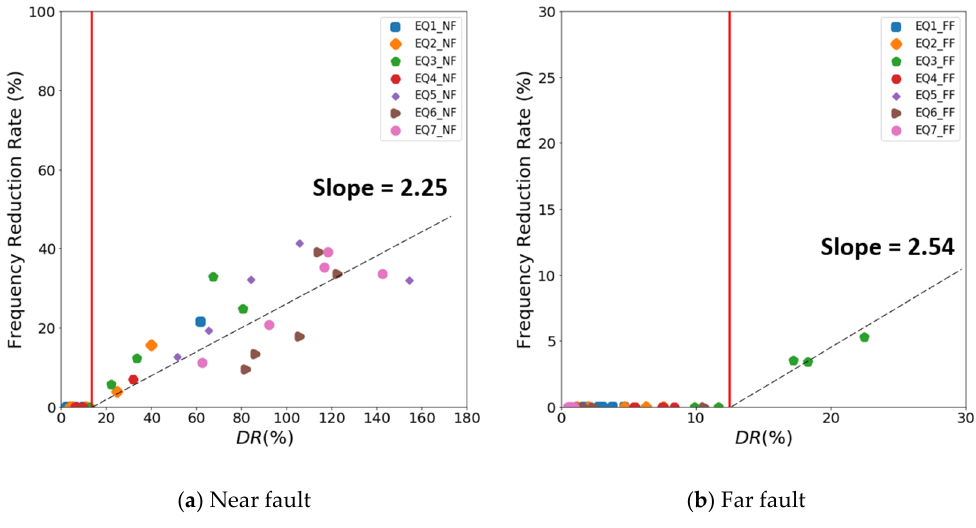
Figure 15. Relationship between the decrease in the natural frequency and the dynamic response ratio ( DR) : ( a , b ) The decrease in the natural frequency and the dynamic response ratio at each ground motions